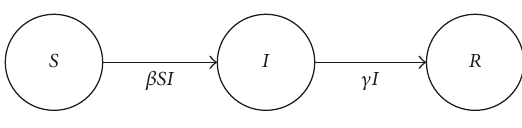
Figure 3: The chart model of